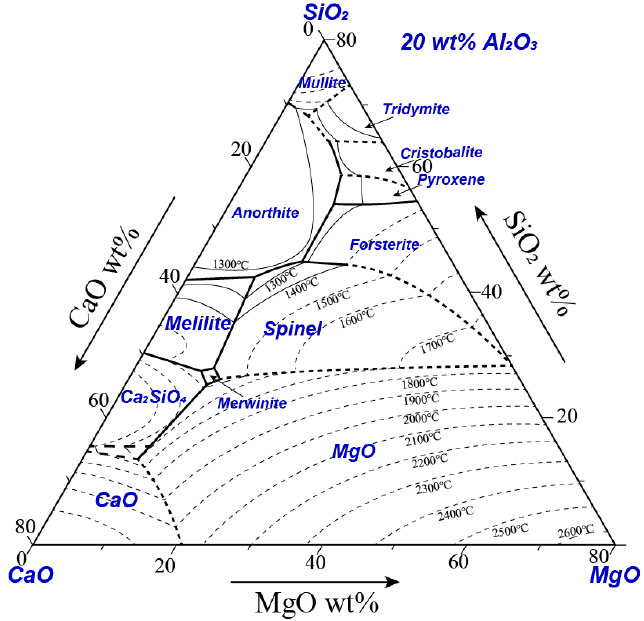
Figure 6. Pseudo-ternary phase diagram CaO-MgO-Al 2 O 3 -SiO 2 for the 20% Al 2 O 3 plane [7].